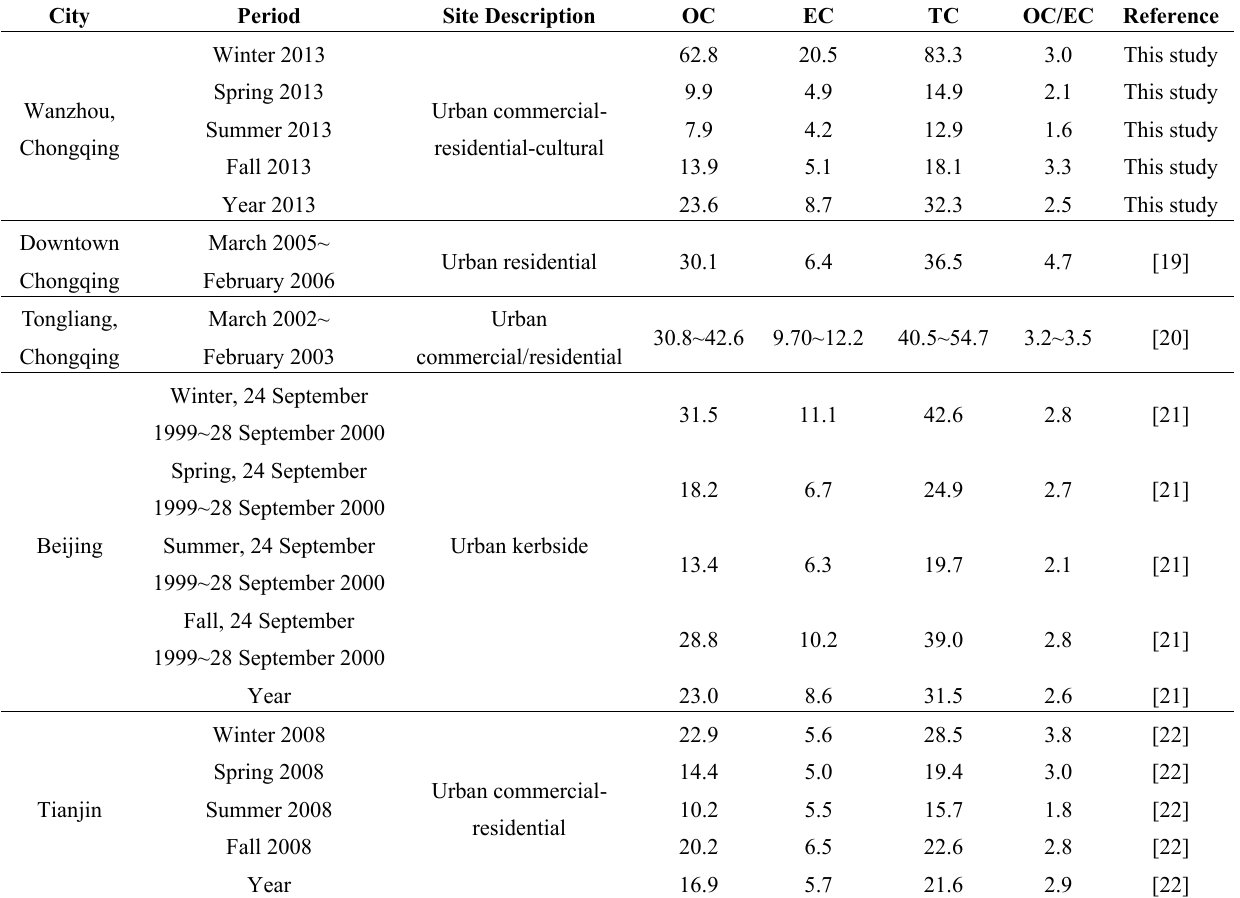
Table 3. Comparison of TC (Total carbon), OC, and EC concentrations in PM2.5 in Wanzhou with those in other Chinese